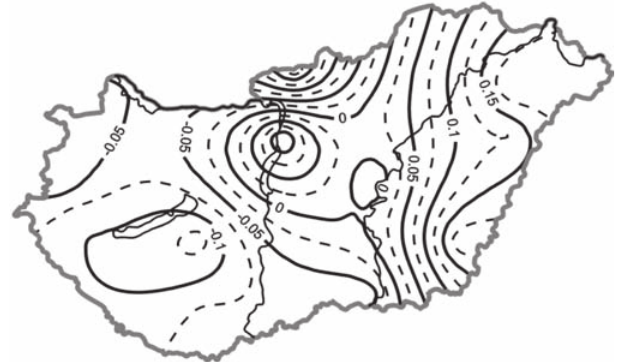
Figure 13 – The spatial distribution of mean daily slope values of the trend-function expressing the changes of the absolute daily maxima of precipitation in autumn according to data raised at 16 stations over